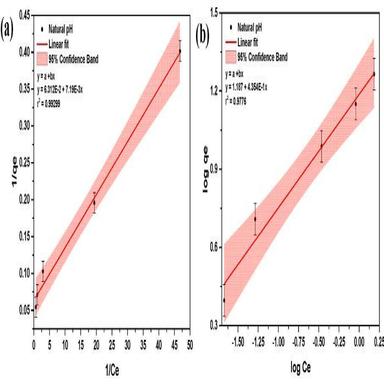
Langmuir isotherm (a) and Freundlich isotherm (b). (A colour version of this figure can be viewed online.)